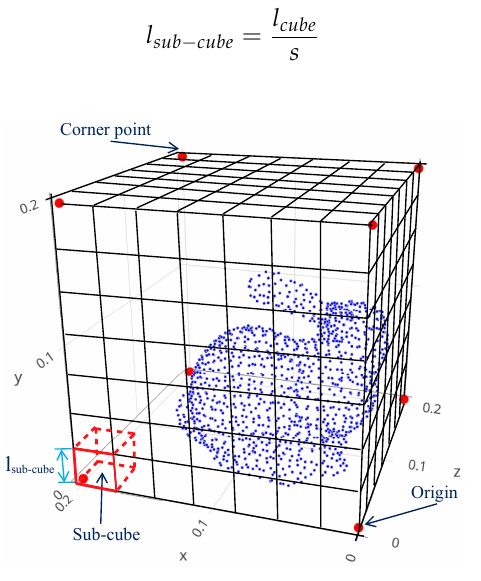
Figure 4. A demonstration about the establishment of cube and sub-cubes in Simplified Spatial Point Distribution (SSPD)